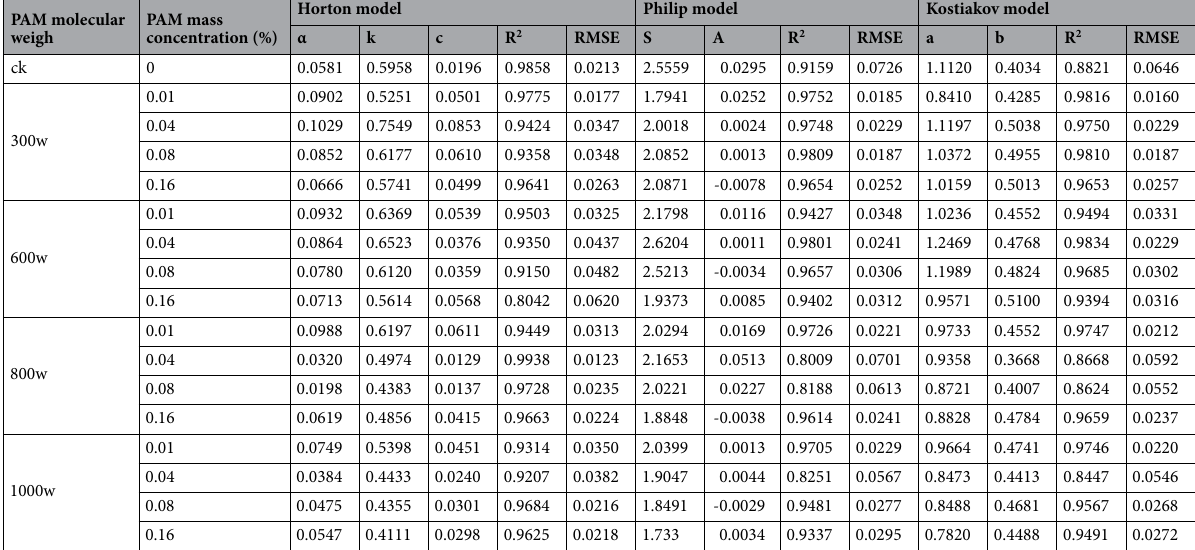
Table 3. Fitting of water infiltration process of iron tailings for four molecular weight (300w, 600w, 800w and 1000w) and five mass concentration (0%, 0.01%, 0.04%, 0.08% and 0.16%) of PAM. α, k, a and b, infiltration experience parameters; S, water absorption rate; A and c, stable infiltration rate; R 2 , coefficient of determination; RMSE, root mean squared